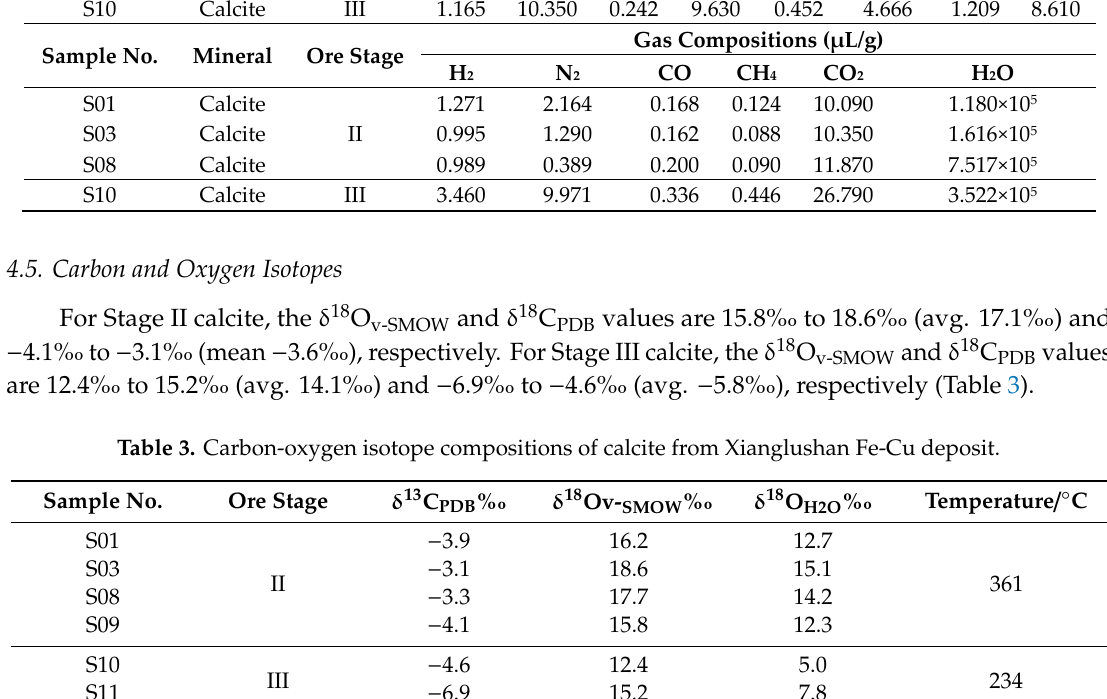
Table 4. Sulfide S-Pb isotope compositions of the Xianglushan Fe-Cu deposit. Sample No.